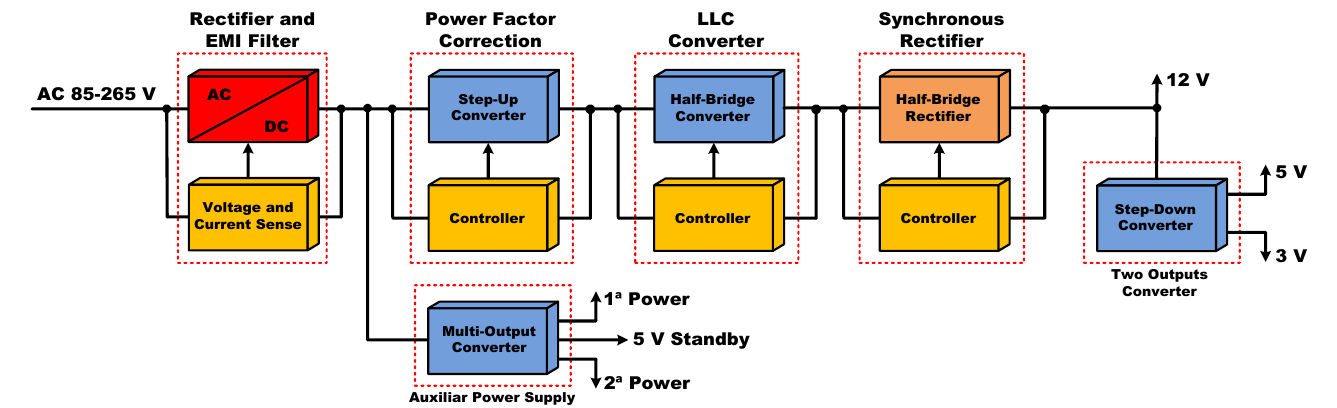
Figure 20. Desktop computer power-supply unit.